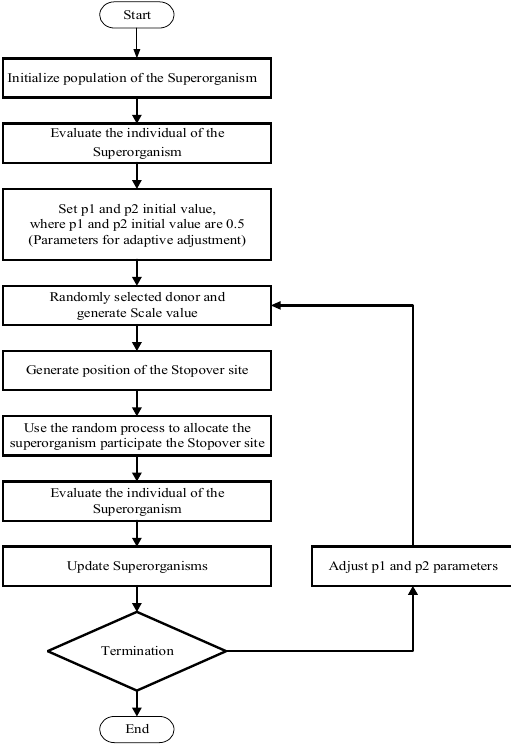
Figure 3. Flowchart of the IDS algorithm.